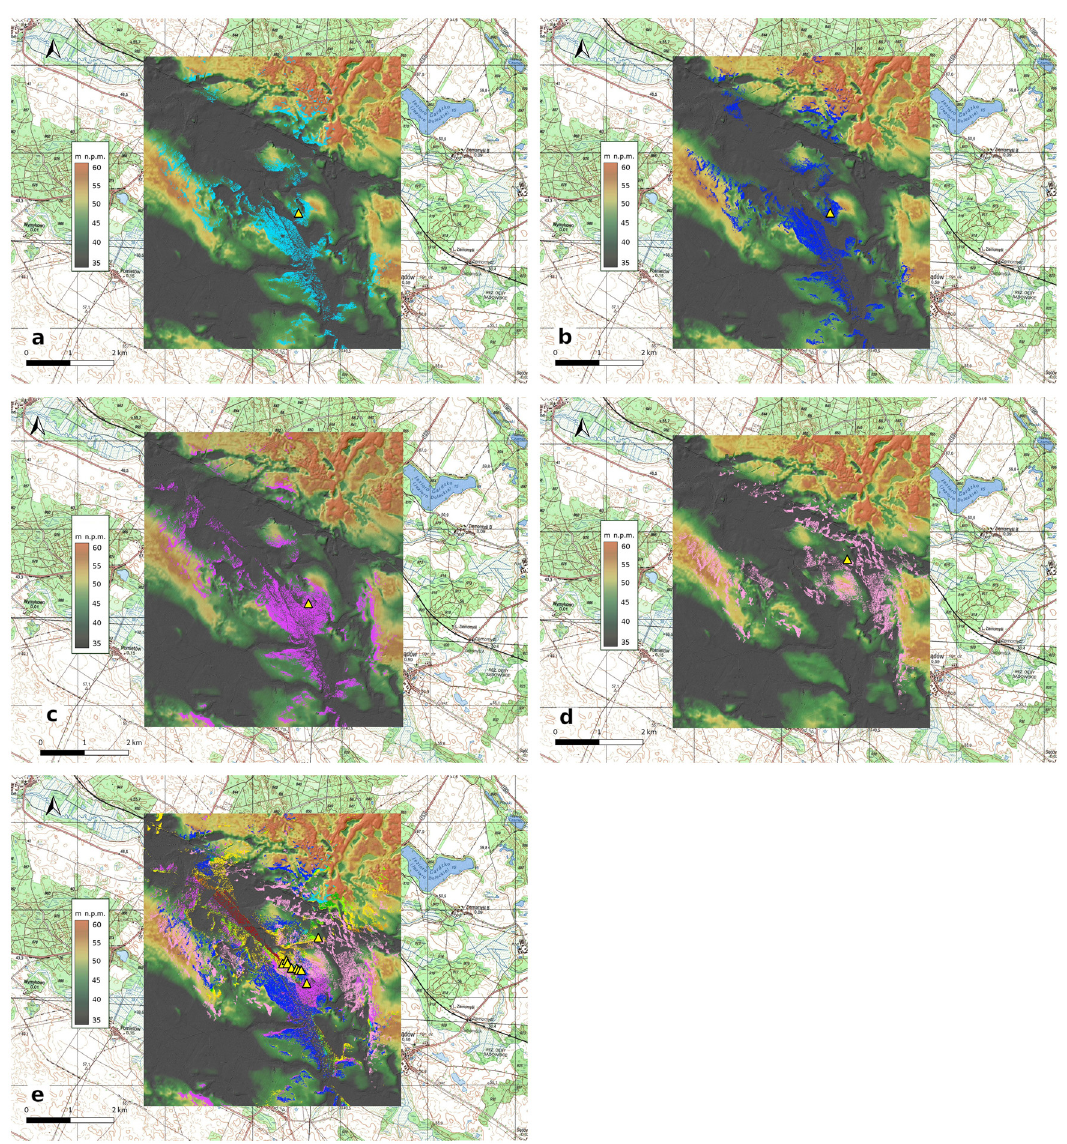
Figure 17: The Dolice - Komorowo South megalithic group. The area visible from the tombs 14 ( a ) , 15 ( b ) , 16 ( c ) and 17 ( d ) , and the juxtaposed views of the group ( e ) ( M. Schiller )